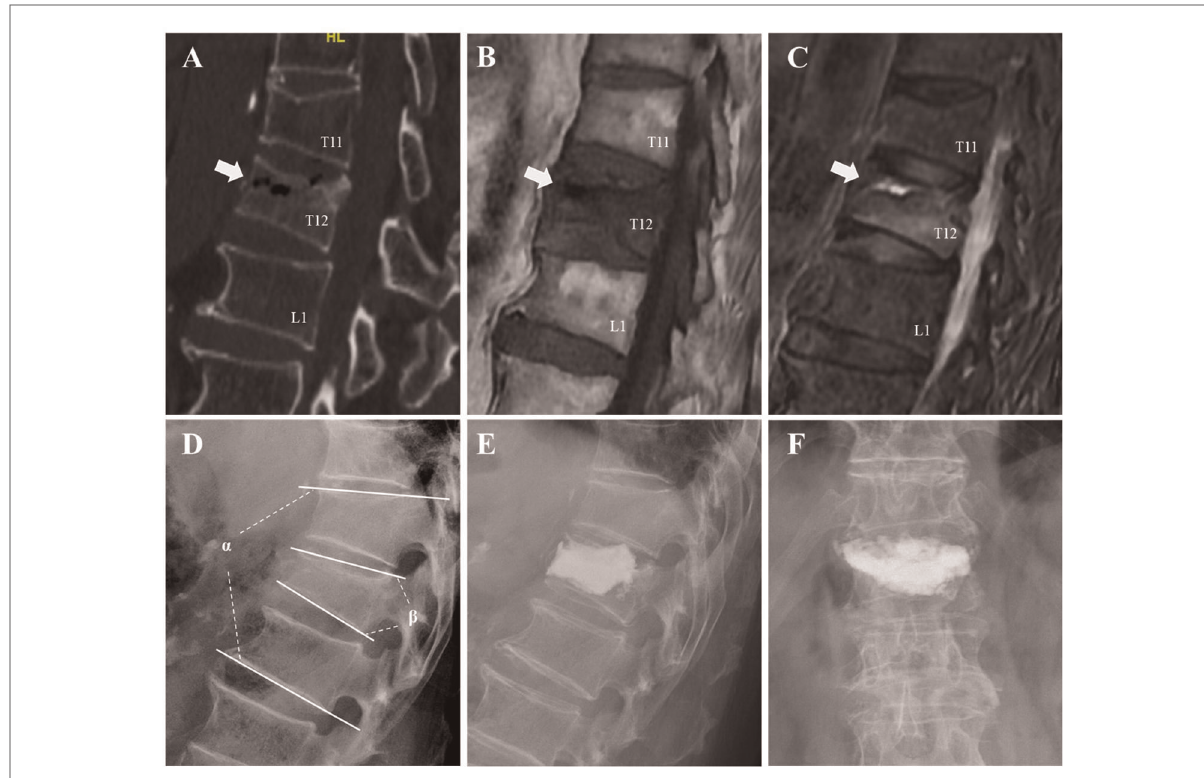
FIGURE 1 An illustrative case of an 81-year-old male patient underwent intradiscal leakage after PKP for OVCFs combined with IVC. A fracture in T12 was detected and the presence of an IVC (the white arrows) was con fi rmed by a gas-like density shown on preoperative CT ( A ), hypointensity shown on preoperative MRI T1-weighted sequences ( B ), and hypointensity shown on MRI T2 short-tau inversion recovery ( C ). Preoperative segmental kyphotic angle ( α ) and vertebral wedge angle ( β ) were measured on lateral radiograph ( D ). Intradiscal leakage was identi fi ed by postoperative radiographs ( E,F